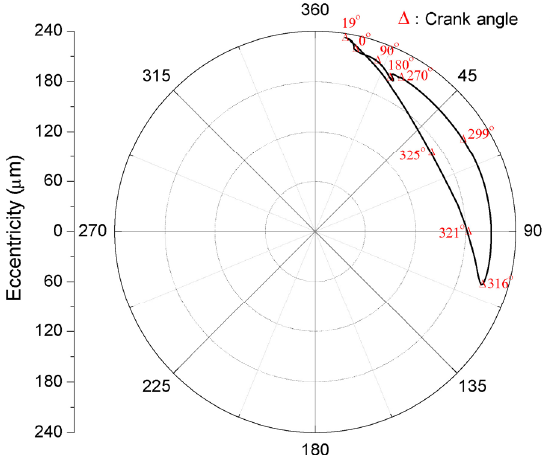
Fig. 7 Orbital path of the crank pin bearing with a clearance of 240 μ m and a lubricant temperature of 40 ° C.